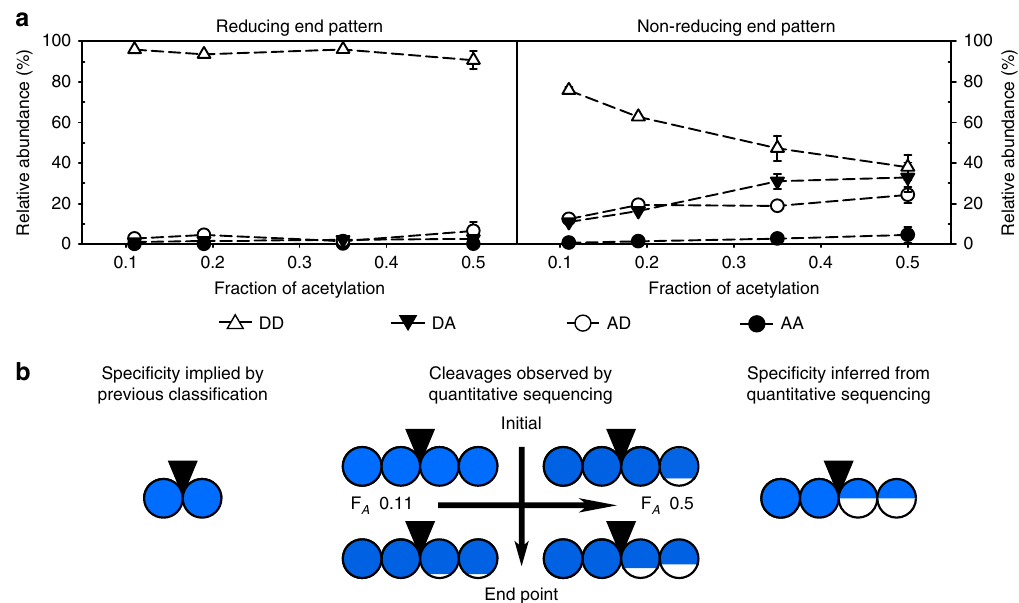
Fig. 3 Speci fi city of the representative class II chitosanase CSN-7M inferred from its products. ( a ) The patterns of acetylation of the two terminal sugar units were analyzed for different F A of the substrates by quantitative sequencing of the products at the endpoint of enzymatic hydrolysis. The molar fractions of all possible diads (DD, DA, AD, and AA) are shown. ( b ) The speci fi city of class II chitosanases implicated by the established qualitative classi fi cation system compared to the speci fi city of CSN-7M (a model class II chitosanase) inferred from the cleavages observed by quantitative sequencing of its products ’ sugar moieties. Diad frequencies at the early time points of enzymatic hydrolysis are taken from Supplementary Table 5. Detailed oligomer compositions are shown in Supplementary Table 2. The circles are divided according to the percentage of the relative abundances (molar fractions) of GlcN (blue) and GlcNAc (white) at the two corresponding subsites, left, ( − 2) and ( − 1), and right, (+1) and (+2), of the catalytic cleavage site (indicated by a black inverted triangle). The mean values with standard deviations of at least three independent measurements of three independent enzyme batches are shown (Supplementary Tables 2 and